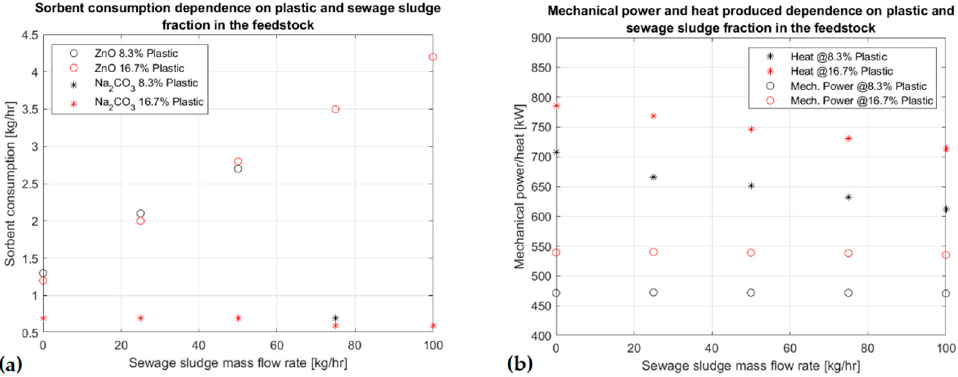
Figure 15. ( a ) Sorbent consumption as a function of plastic and sewage fraction; ( b ) mechanical power and heat recovered as a function of plastic and sewage fraction.